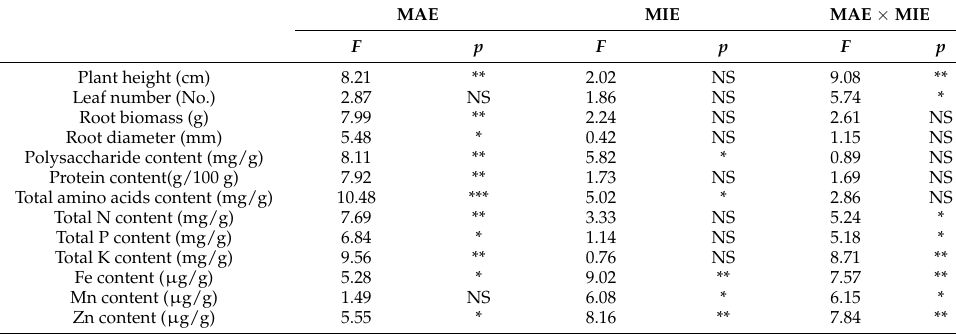
Table 1. Two-way ANOVA of the effect of MAE and MIE on plant growth and chemical composition parameters of Chinese